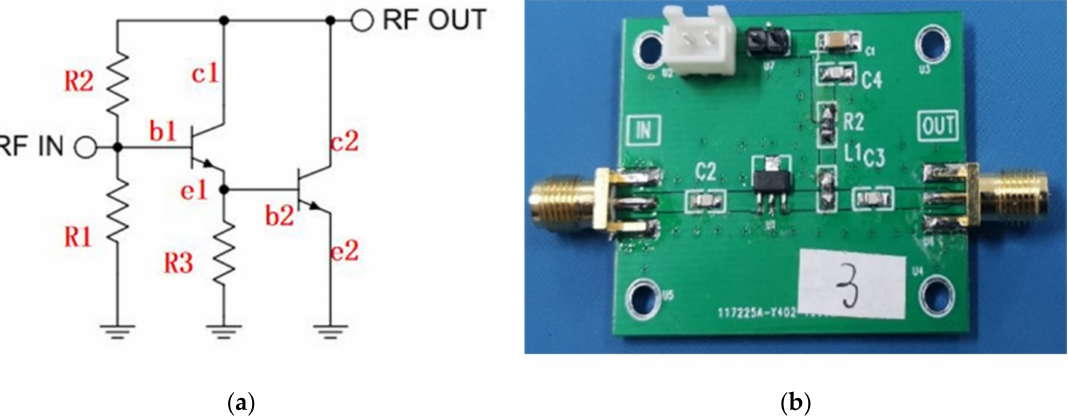
Figure 3. RF3376 with GaAs HBT as DUT: ( a ) circuit structure inside the RF3376 chip; ( b ) the DUT for the PCI test.